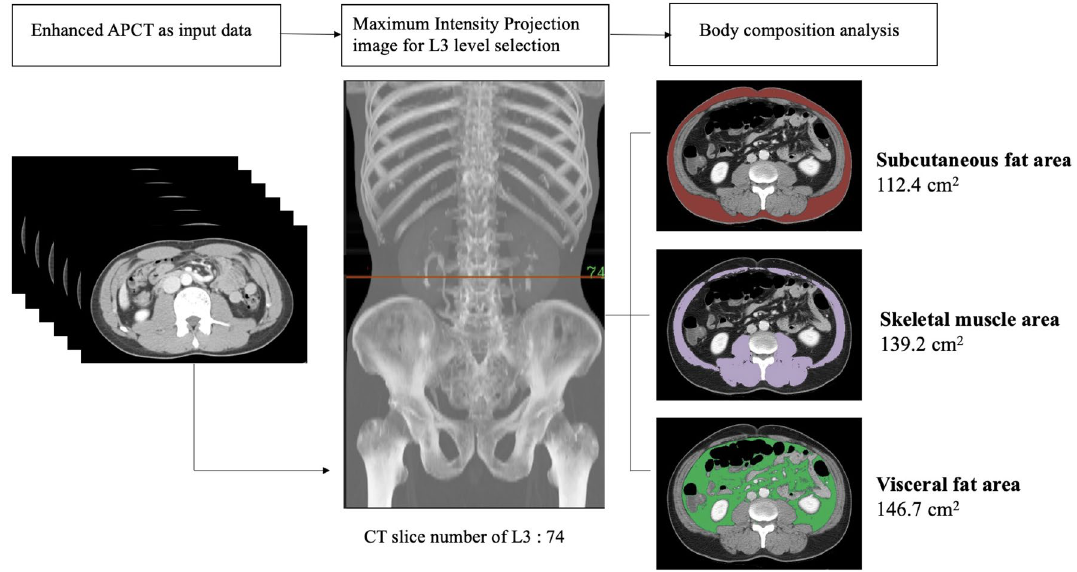
Figure 4. Example of L3 level selection and body composition analysis using L3SEG-net. APCT was converted to a MIP image. L3 level was selected by YOLOv3 based selection algorithm and selected CT slice number was transferred to FCN based segmentation algorithm. The final output of L3SEG-net was areas of each composition element including subcutaneous fat area, skeletal muscle area, and visceral fat area. APCT abdominopelvic computed tomography, MIP maximal intensity projection.